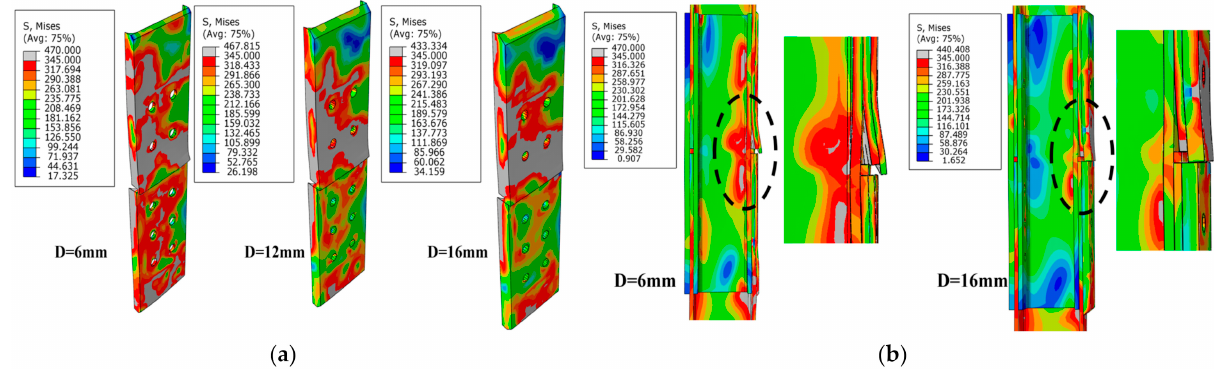
Figure 16. Mises stress distribution of modular connections: ( a ) Beam end plate; ( b ) Joint